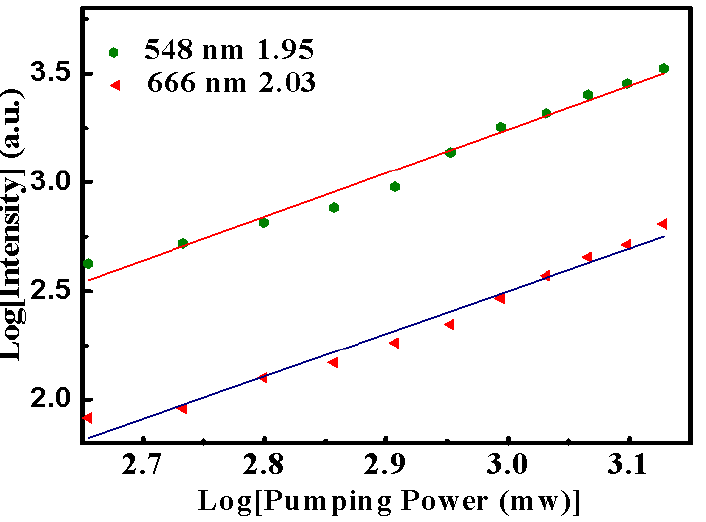
Figure 3. Double logarithmic plot of the pumping power dependence of upconversion luminescence intensities (for the green emission at 548 nm, and the red emission at 666 nm) in In:Yb:Ho:LiNbO